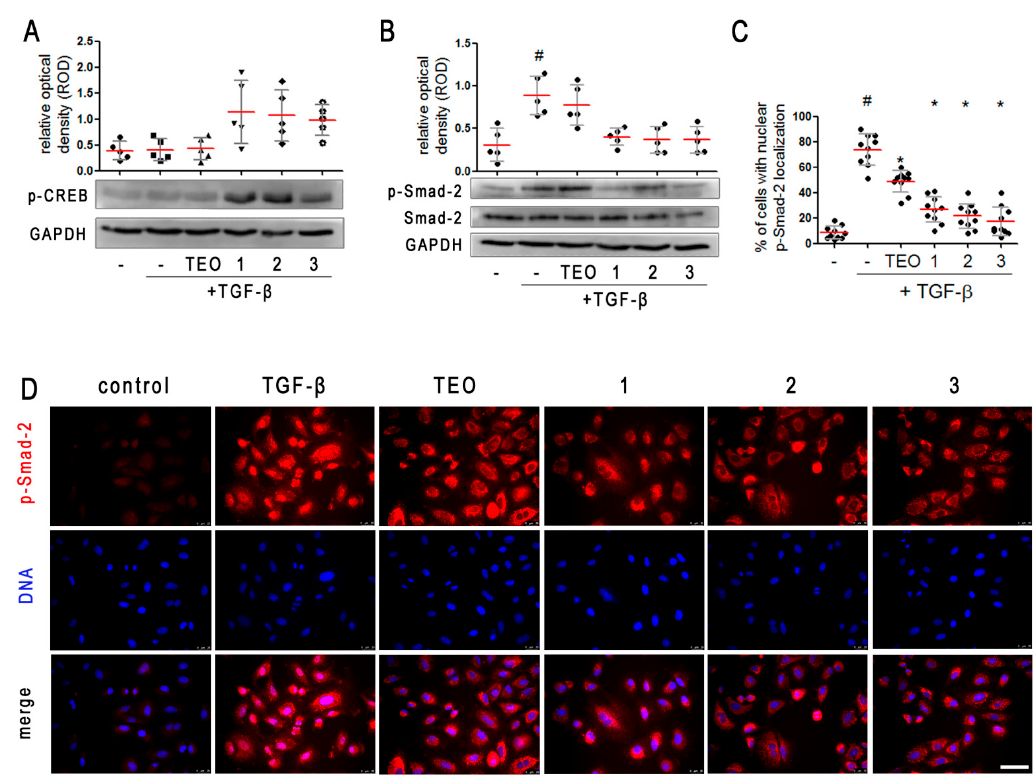
Figure 6. Pan-PDE inhibitors attenuate TGF- β -induced Smad-2 signaling in alveolar epithelial type II cells. A549 cells were cultured overnight and then serum-deprived for 24 h. 1 , 2 , 3 , or TEO (10 μ M) was administrated 1 h before TGF- β (5 ng/mL) treatment for an additional 1 h incubation. Representative immunoblots and densitometry analysis of p-CREB ( A ) and p-Smad-2 ( B ) in A549 ( n = 5). The relative optical density was normalized to the GAPDH control level. Horizontal lines represent the median with interquartile range (Kruskal–Wallis test with Dunn’s post-hoc test). ( D ) Representative images (400 × magnification) of A549 immunostained for p-Smad-2. Cells were fixed, permeabilized, blocked, and incubated with anti-p-Smad-2 antibody followed by an Alexa Fluor 546 conjugated antibody, and nuclei were co-stained with Hoechst 33342 dye. Scale bar = 50 µ m. ( C ) Cells exhibiting colocalization of p-Samd-2 and nuclear signal were counted in randomly selected fields of view and expressed as a percentage fraction in the entire A549 population. Horizontal lines represent the mean value ( ± SD), n = 10 (ANOVA with Dunnett’s post-hoc test). The results were considered statistically significant at the p -level of 0.05, against the control (#) and TGF- β (*)